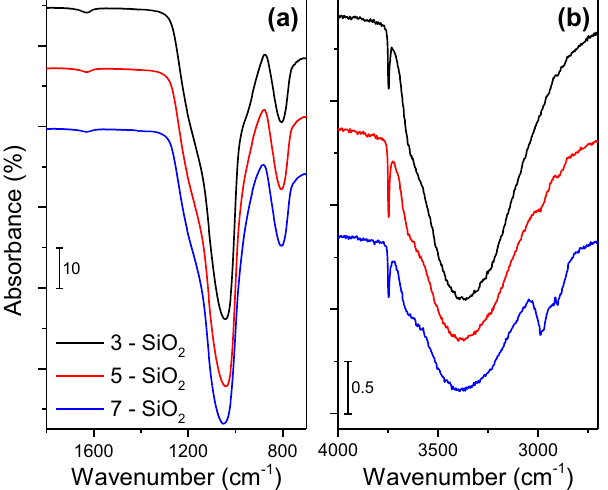
Figure 2. FTIR spectra of as prepared 3, 5 and 7-SiO 2 showing the ( a ) 1800–700 cm −1 and ( b ) 4000–2700 cm −1 wavenumber